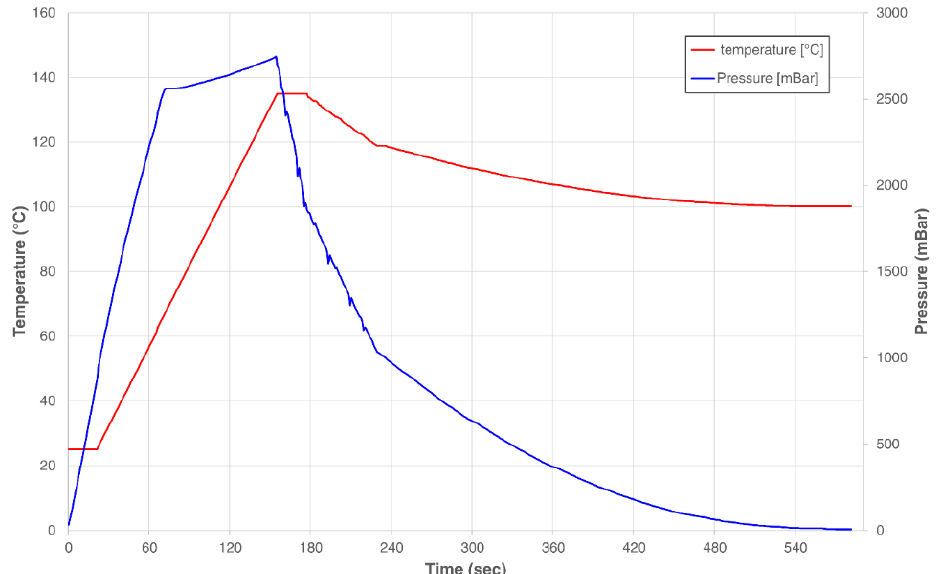
Figure 10. Heating and pressure profile of the microwave-assisted extraction procedure.